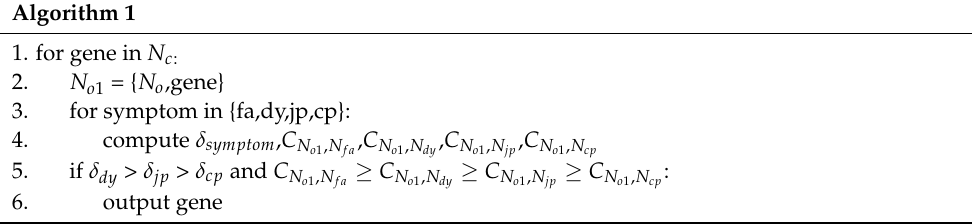
relation scores between COVID-19 and long-COVID symptoms in China. The x-axis represents the iteration times, and the y-axis represents the correlation scores. The rank of the correlation scores between COVID-19 and long-COVID symptoms in both Europe and China obtained by the random walk algorithm with restart are inconsistent with the frequency of symptoms reported in the paper